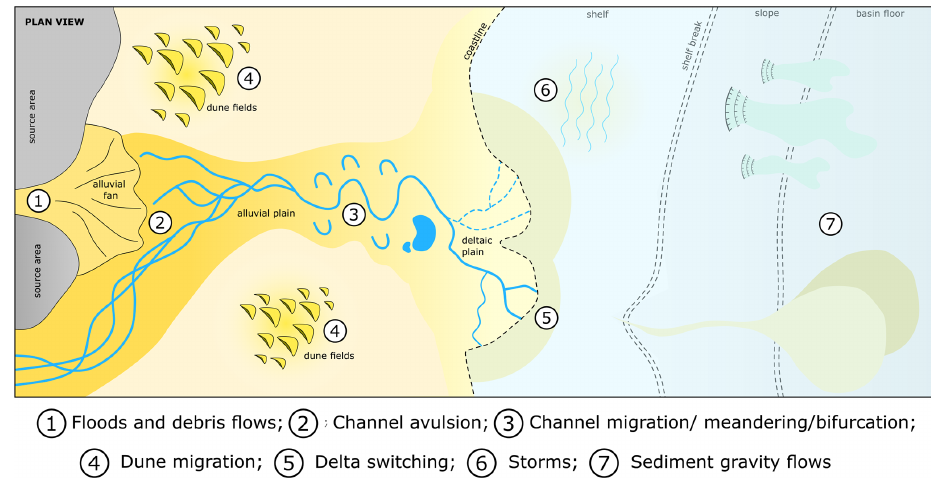
Figure 16. Schematic illustration with some autogenic controls on sedimentation in different environments.